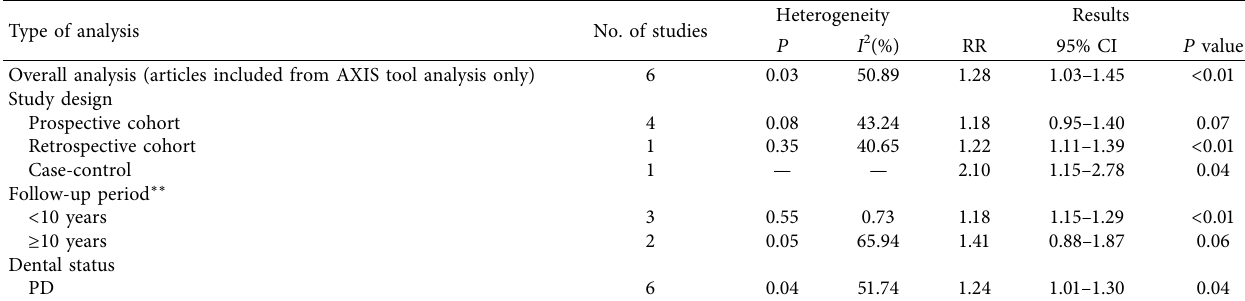
Figure 2: Summarisation of the overall results of articles included in AXIS tool analysis. Table 2: Overall data from AXIS tool conducted studies ∗ . Calculated relative risk (RR), 95% CI and P values investigating the efcacy of FN from the oral microbiome and its biomarker potential for breast cancer in adult